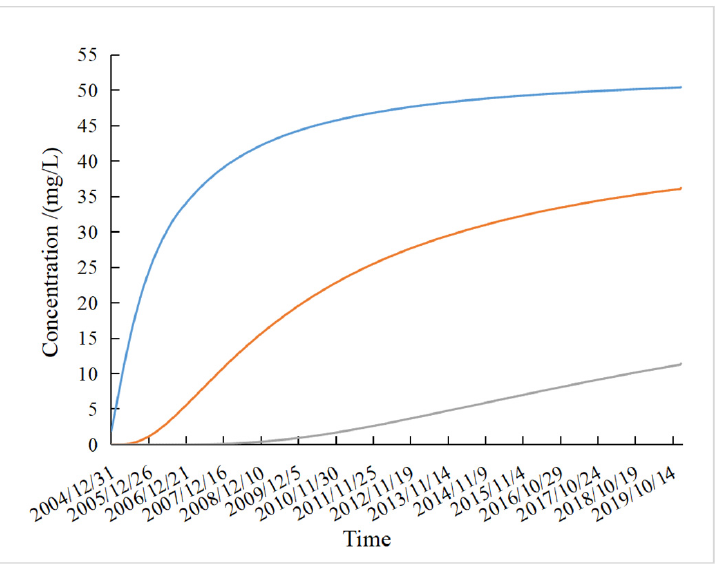
Figure 10. Variation of pollutant concentration in three observation wells.